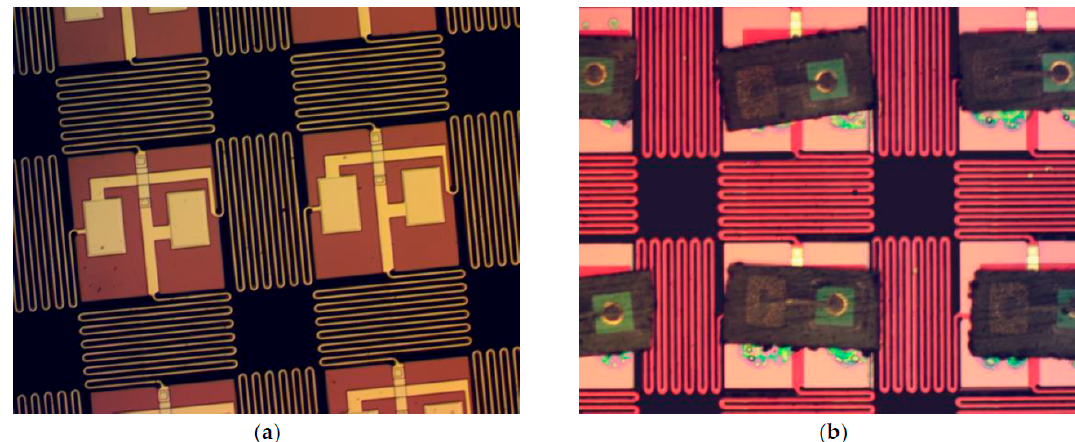
Figure 4. Microscope image of some silicon islands and springs with metal interconnects running over the springs. Individual islands are 600 µm × 600 µm ( a ) Before SMD LED’s are soldered; ( b ) After SMD LED’s are soldered. The method used to apply the solder, is based on an SU-8 solder